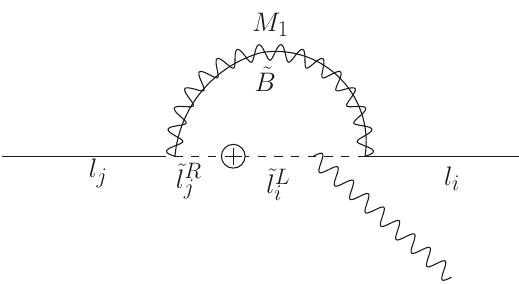
Figure 1. Slepton and neutralino induced Feynman diagram for the process l j